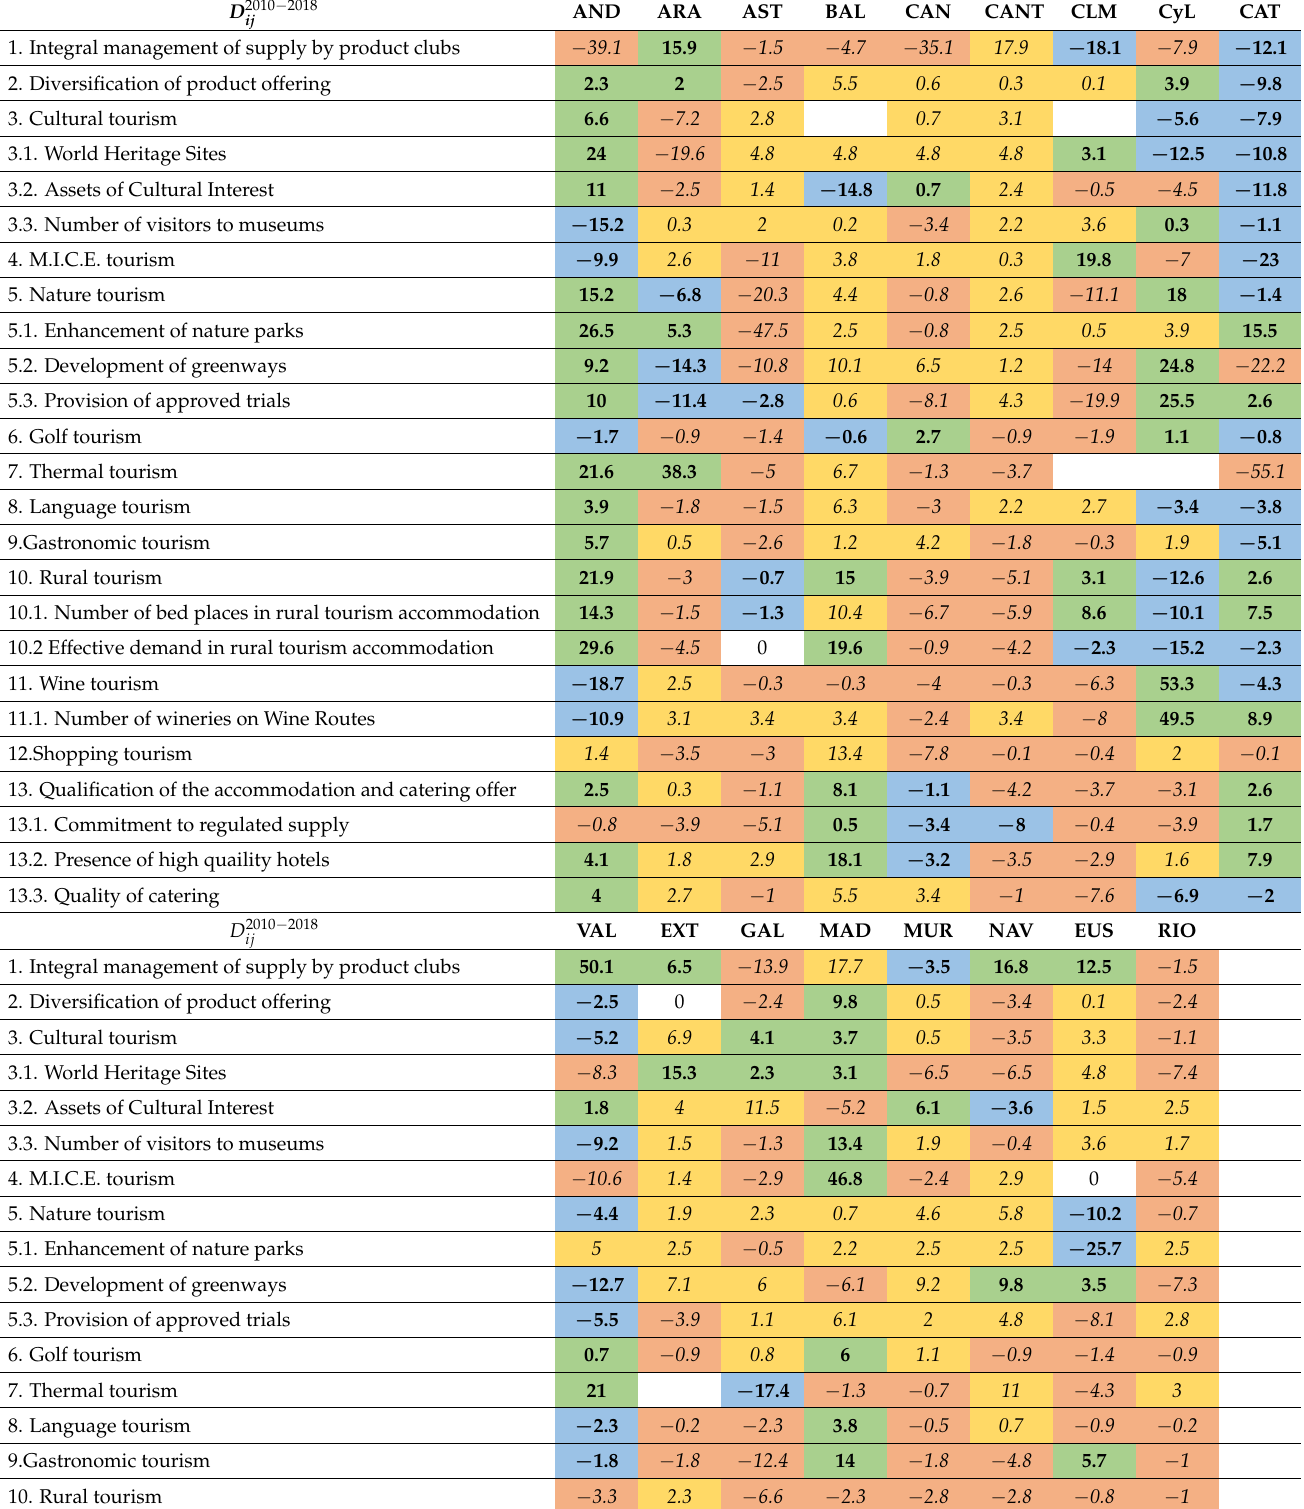
Table A1. Competitive scenarios for spanish regions between 2010 and